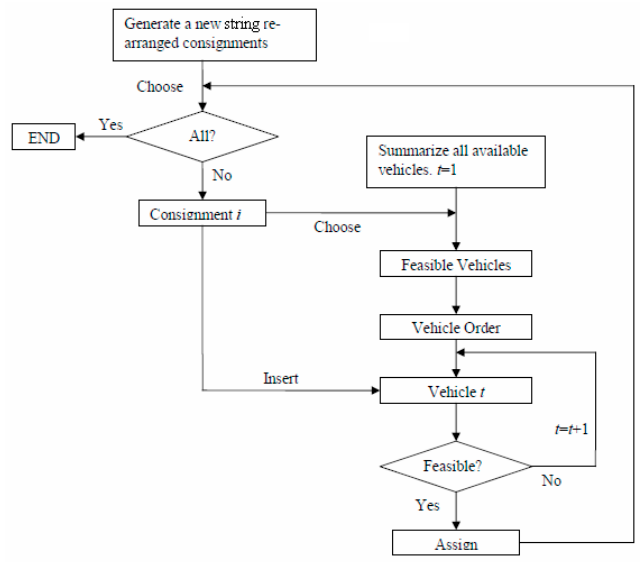
Figure 4. Procedure of dynamic adjustment.